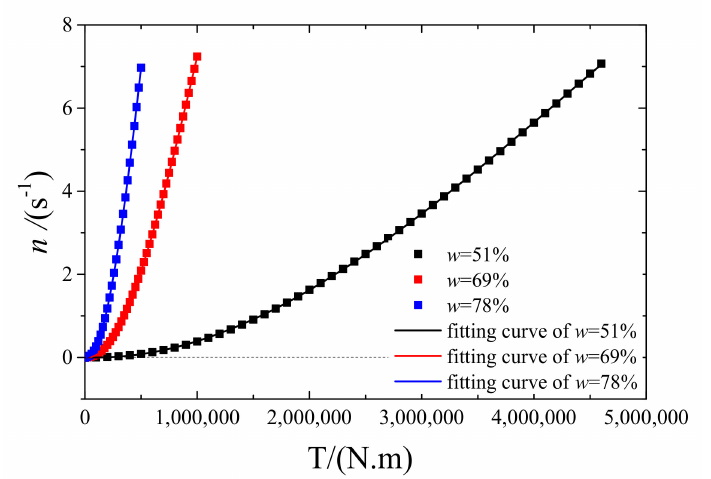
Figure 7. Torque and